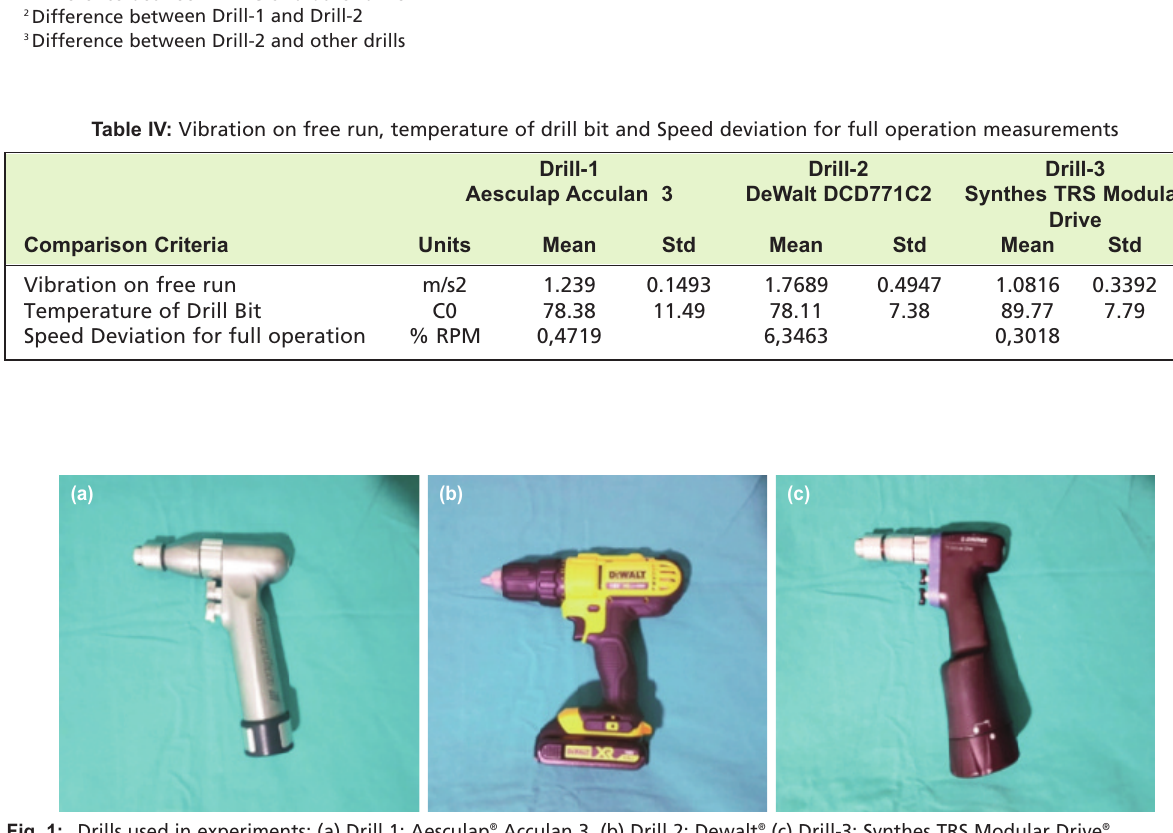
Drills used in experiments: (a) Drill 1: Aesculap ® Acculan 3. (b) Drill 2: Dewalt ® (c) Drill-3: Synthes TRS Modular Drive ® Fig. 1: